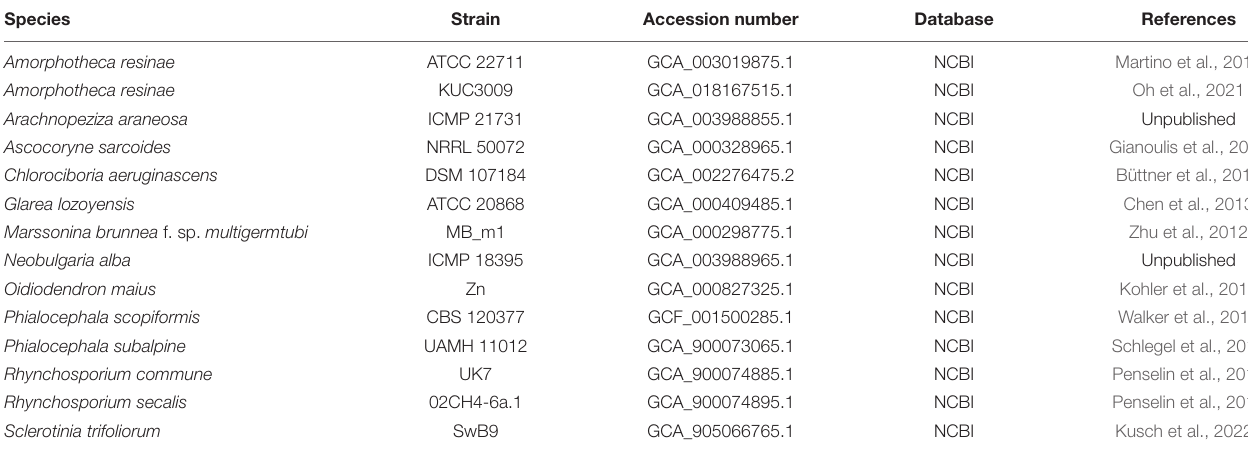
TABLE 3 | List of non-powdery mildew Leotiomycete genomes included in the genome-scale phylogenetic analysis. Species